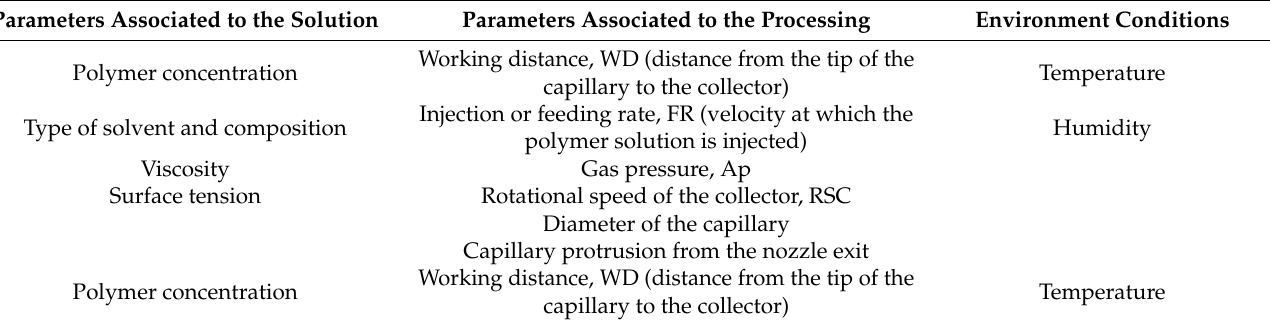
Temperature Humidity